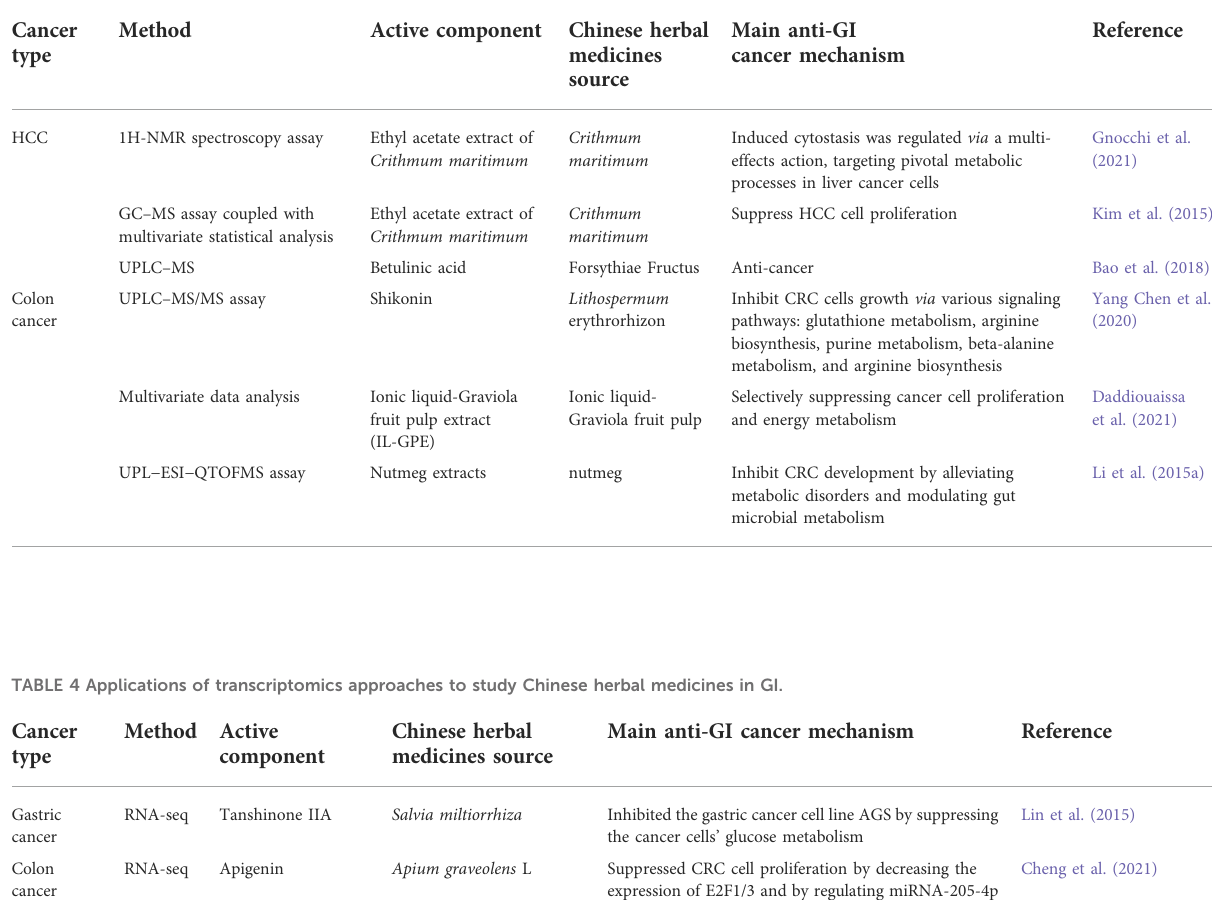
TABLE 3 Application of metabolomics approaches to study Chinese herbal medicines in GI